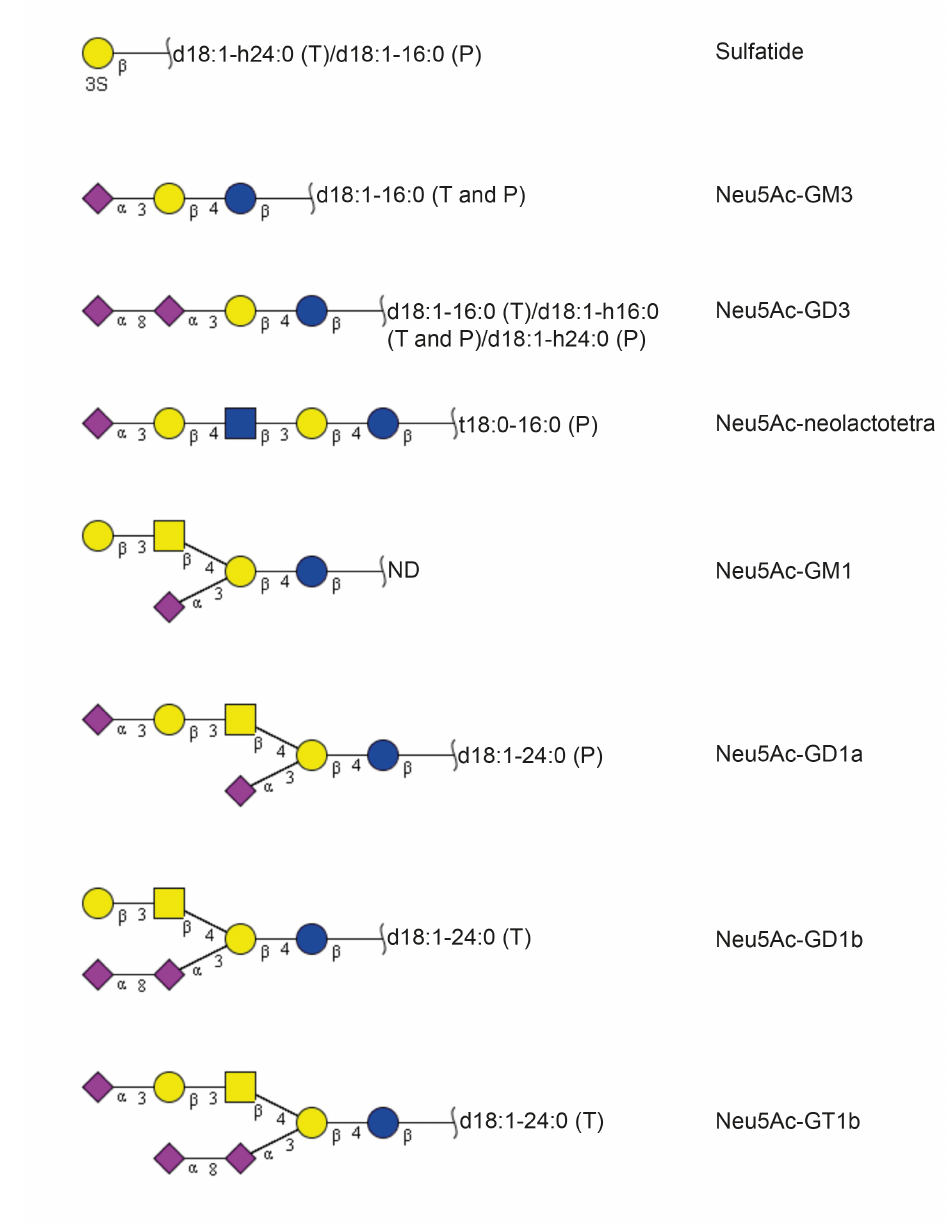
e.g., h16:0. For the long chain bases, d18:1 is sphingosine (1,3-dihydroxy-2-aminooctadecene) and t18:0 is phytosphingosine (1,3,4-trihydroxy-2-aminooctadecane). T denotes thyroid gland, PT